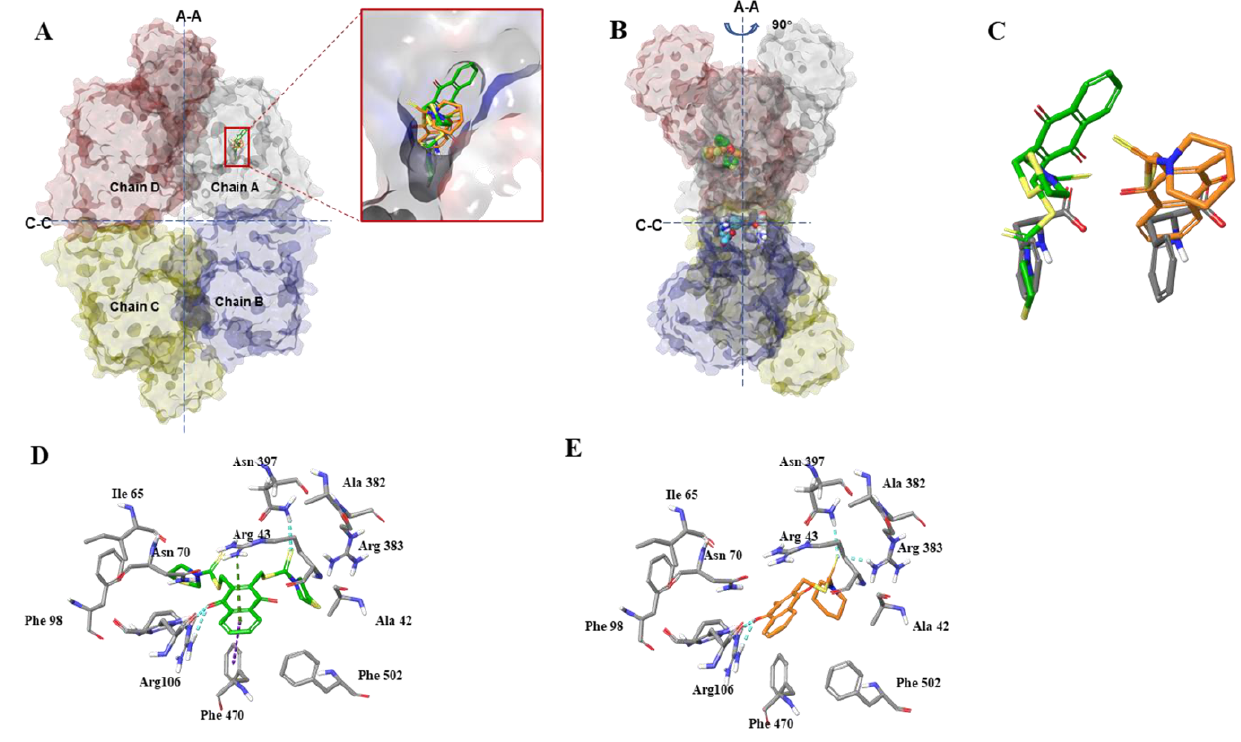
Figure 5. Binding mode of compounds 3h and 3K in the effector phenylalanine-binding site of PKM2. ( A ) Superimposition and enlarged view of phenylalanine (gray sticks), compound 3h (green sticks), and compound 3K (faded orange sticks) over the X-ray of PKM2. PKM2 tetramer is shown with the effector site complexed with the original ligand phenylalanine (gray sticks), compound 3h (green sticks) and compound 3K (faded orange sticks). The chain is colored, light gray is for Chain A, cyan Chain is for B, green is for Chain C, magenta is for Chain D. The large (A-A) and small (C-C) interfaces between monomers are shown as dashed lines. ( B ) Side view (rotated 90° to that of A) of PKM2 tetramer complexed with the original ligand phenylalanine (gray sticks), and compound 3h (green sticks) and compound 3K (faded orange sticks). ( C ) Superimpositions of phenylalanine (gray) and compound 3h (green) or 3K (faded orange). ( D , E ) Close-up view of the key interactions involved in bonding with compound 3h ( D , green sticks) and compound 3K ( E , faded orange sticks) in effector-binding pocket. Key residues surrounding compound 3h and 3K are shown as gray sticks and labeled. π - π stacking is depicted by dotted purple lines. π -cation is shown as dotted dark green lines. Hydrogen bonds are depicted as dotted cyan lines.